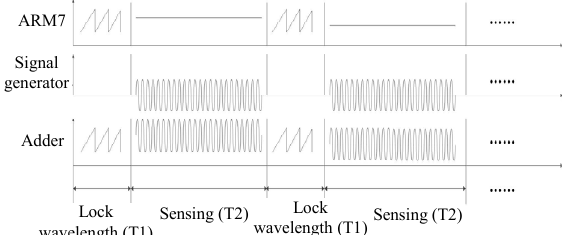
Fig. 2 Driver signals at gas absorption center calibration and sensing.